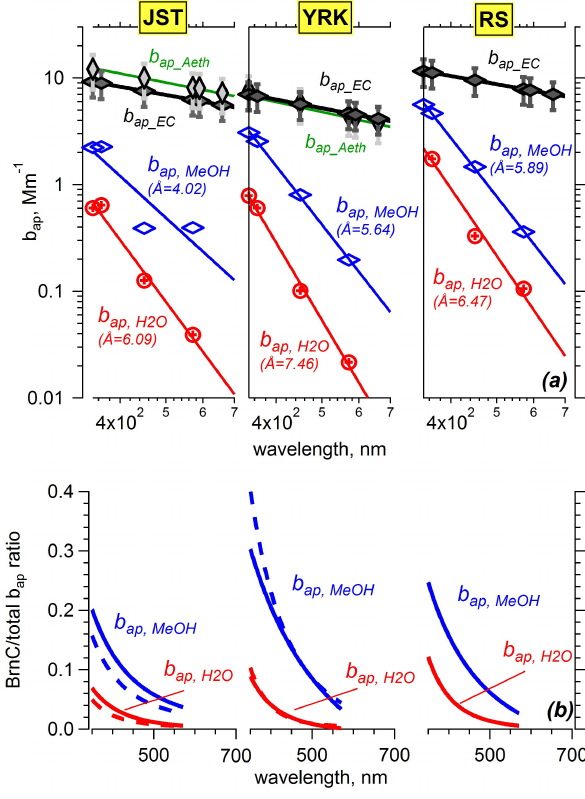
Fig. 6. (a) Mie-predicted absorption of methaol-soluble brown car- bon, water-soluble brown carbon, and BC absorption from EC data, and Aethalometer-measured BC absorption, all at the 7 wave- lengths of the Aethalometer. (b) contribution of brown carbon (water soluble and methanol soluble) to total light absorption at JST, YRK and RS sites, where solid lines show the relative frac- tion to EC plus BrnC (e.g., b ap , MeOH /(b ap , MeOH + b ap_EC ) , or + b b ap , H /( b ap , H ap_EC )) , and dotted lines show the fraction 2 O 2 O relative to Aethalometer absorption (e.g., b ap , MeOH /b ap_Aeth or b ap , H /b ap_Aeth ) . No Aethalometer data were available at the 2 O RS site. For JST and YRK, where multiple MOUDI measurements were made, averages are plotted. Error bars are based on calcula- tions summarized in Table 2, where additional estimates of errors can be